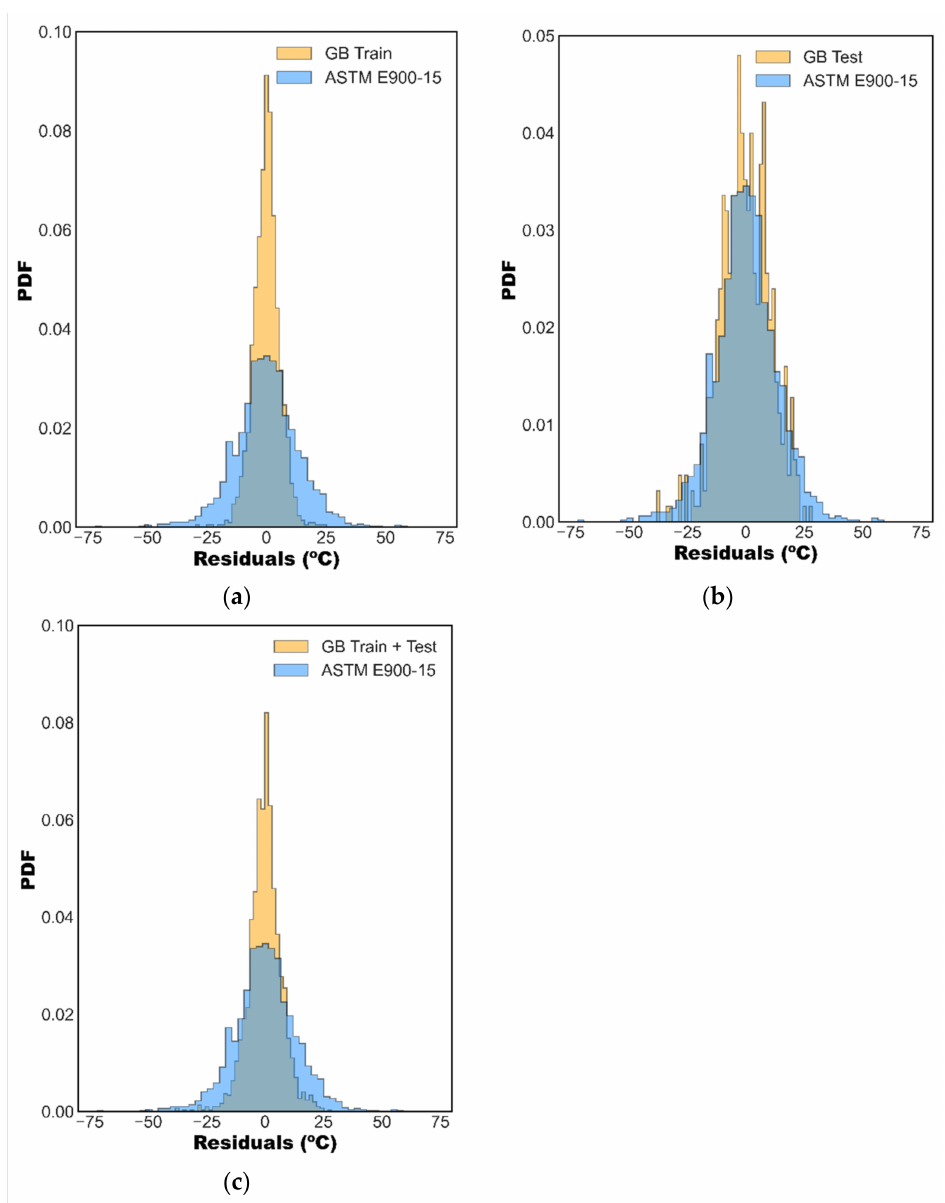
Figure 7. Comparison of residuals obtained from the GB algorithm and the ASTM E900-15 ETC. ( a ) Train dataset, ( b ) test dataset, ( c ) all